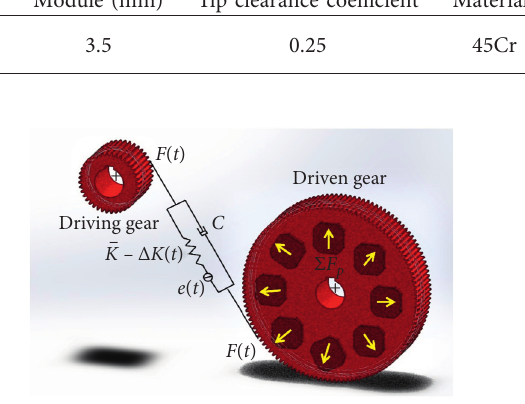
Figure 2: Gear transmission vibration